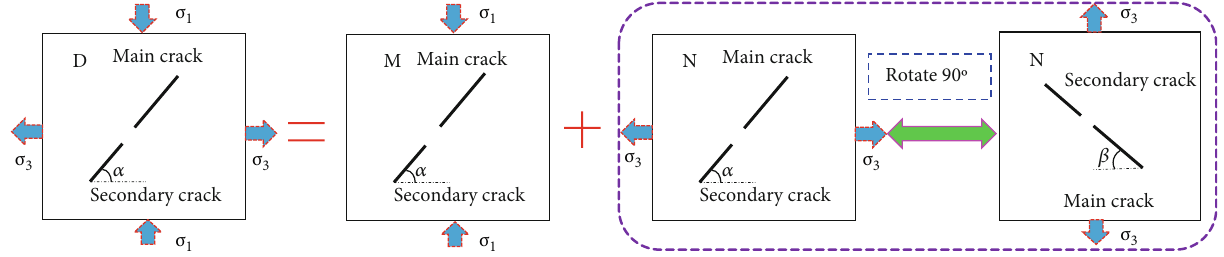
Figure 3: Secondary superposition of the stress state of a double cracked rock mass under unloading condition.